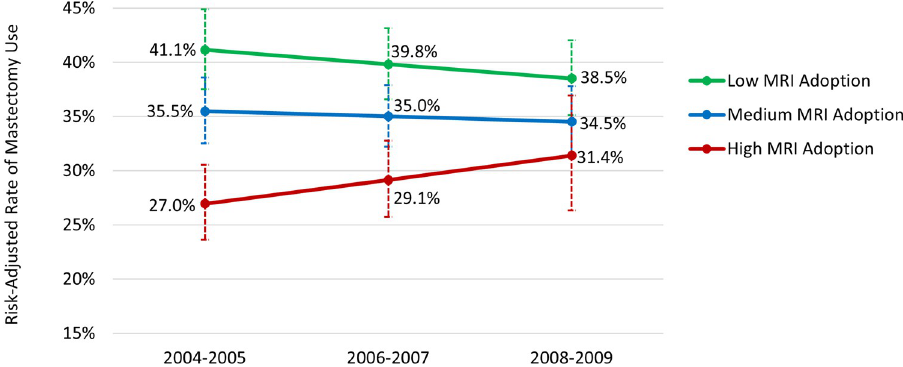
Fig 3. Risk-adjusted proportion of patients using mastectomy over time, by the distinct trajectories of MRI adoption. MRI = magnetic resonance imaging. Error bars reflect 95% confidence